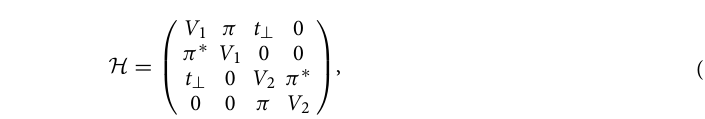
Figure 1. ( a ) Top and ( b ) side view of the schematic representation of the possible thermoelectric device based on bilayer graphene double barriers. The double barrier structure generated by the top gates is sandwiched between hot and cold leads. ( c ) Crystal structure of Bernal-stacked bilayer graphene, with γ 0 and γ 1 = t ⊥ as the main interactions between carbon atoms. ( d ) Band-edge profile of the conduction band of ( a ). Here, V 0 = V 1 = V 2 represent the potential energy on the bilayer graphene layers, respectively, also the potentials V 1 and V 2 are less than t ⊥ and therefore the bands can be considered as paraboloids. d B and d w represents the widths of the barrier and well regions, respectively. x L and x R correspond to the left and right ends of the